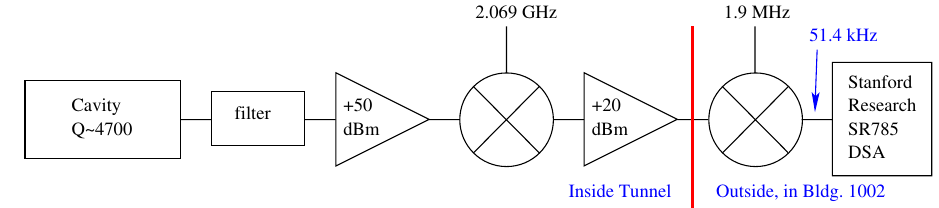
FIG. 2. (Color) Block diagram of the signal processing. The filter, two amplifiers, and the first mixer are located inside the tunnel. The second mixing stage is done in the support